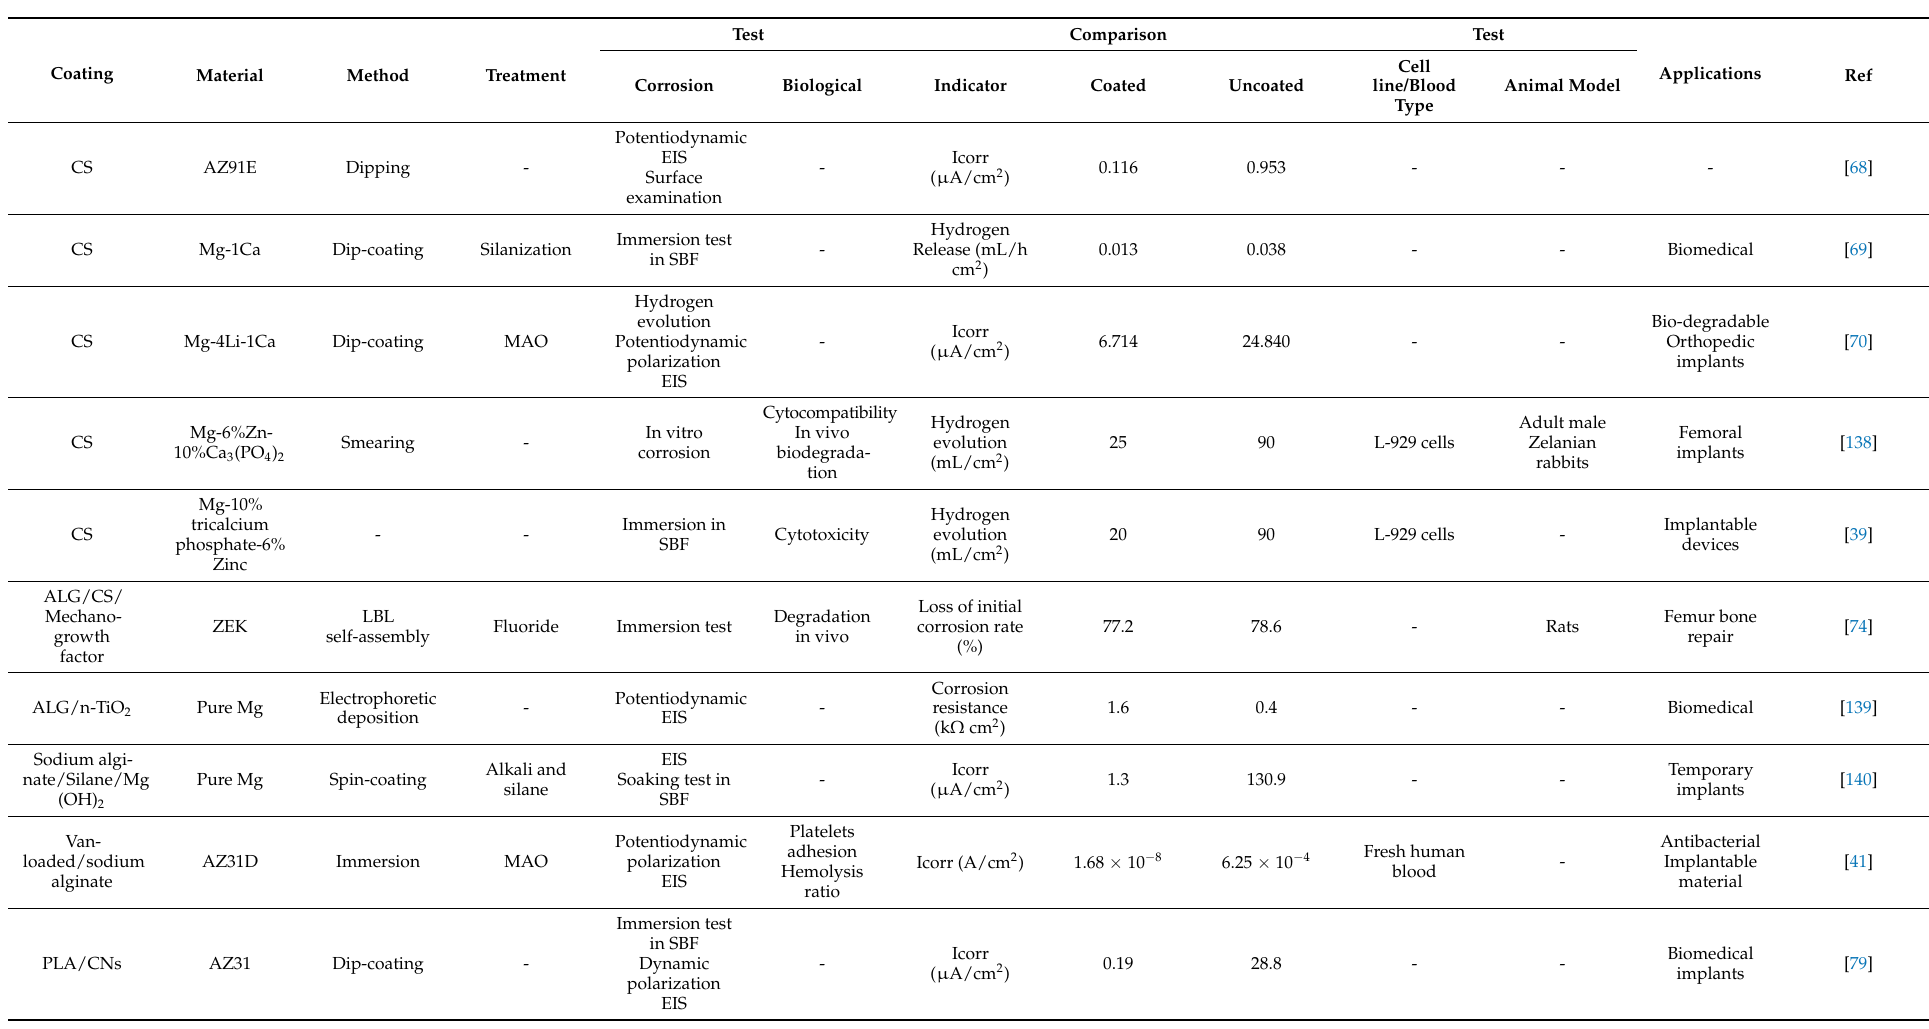
Table 2. Natural coatings on Mg